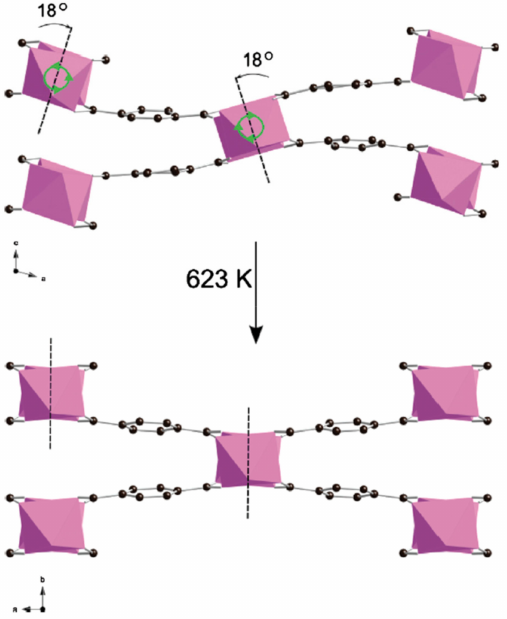
Figure 9. E ff ect of heating on Sc–OH–Sc chain in MIL-53(Sc). The dashed line represents the plane of the infinite Sc–O–Sc chains